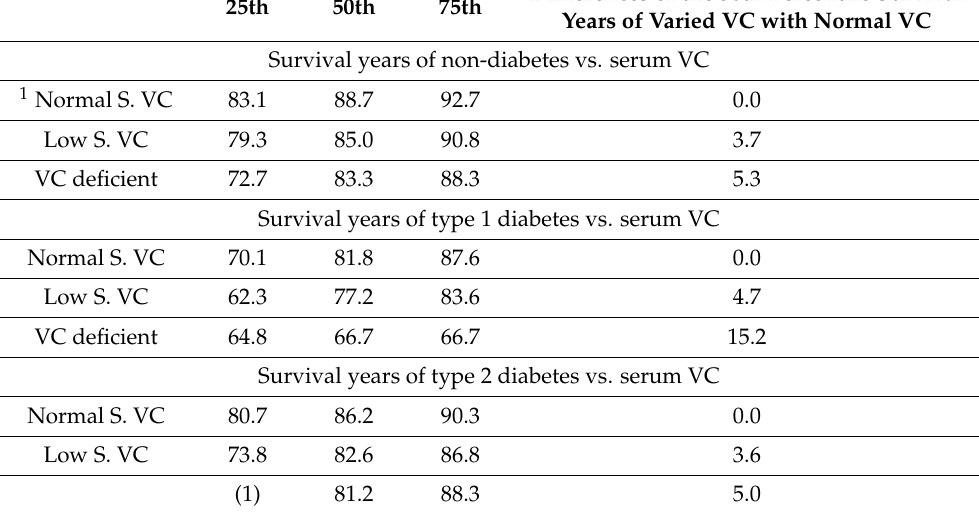
Table 6. Survival years of 25th, 50th (median), and 75th percentiles of US adults vs. their total VC intakes and serum VC levels. Differences of the 50th Percentile Survival 25th 50th 75th Years of Varied VC with Normal